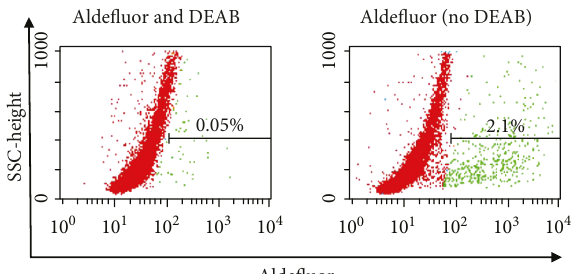
Figure 1: Flow cytometry analysis of ALDH activity in cells isolated from a human cardiac atrial appendage tissue specimen using the Alde fl uor ™ assay. (a) ALDH br gating is established by incubating Alde fl uor ™ -reacted cells with the ALDH inhibitor DEAB (negative control). An ALDH/side scatter (SSC) plot is shown. ALDH br gating was set to include the top 0.05% of DEAB-treated cells with respect to the intensity of the fl uorescent signal. (b) Alde fl uor-reacted cells analyzed in the absence of DEAB